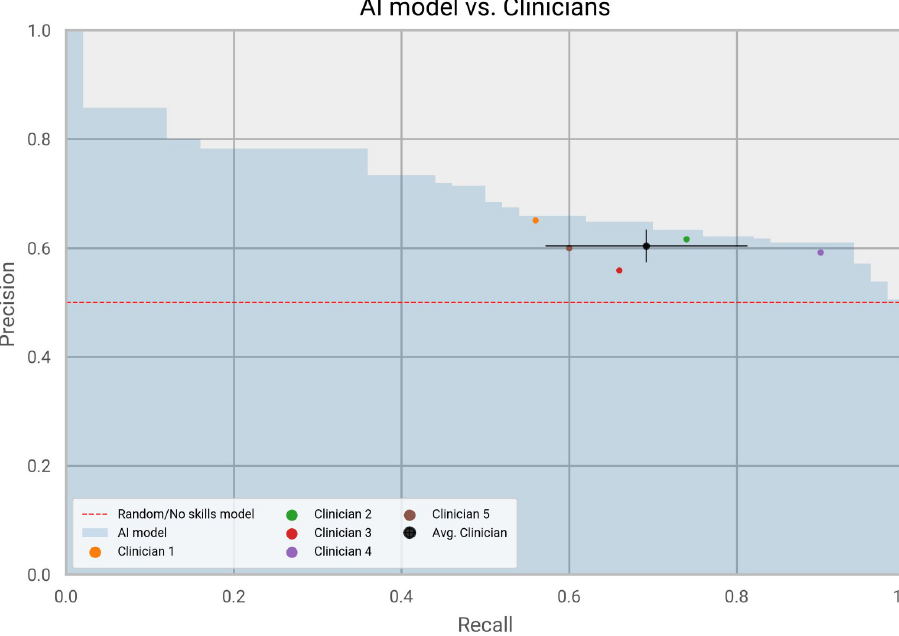
Fig 7. Machine learning vs. clinicians. Performance comparison between the machine learning model and five